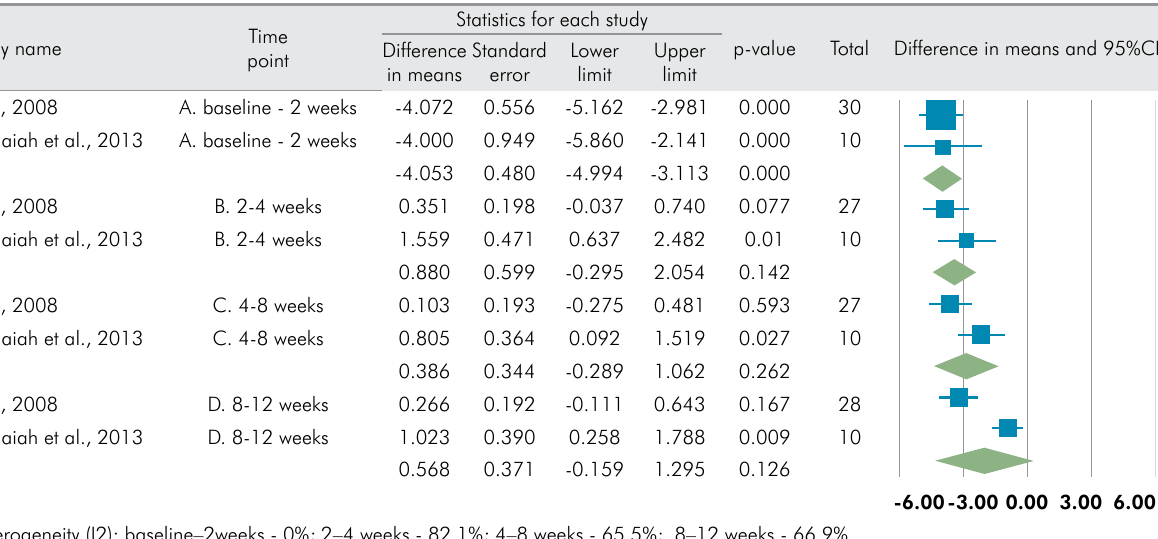
Figure 4. Comparison of measurements for the following time intervals: baseline–2, 2–4, 4–8, and 8–12 weeks of treatment. A: Data are presented in millimeters; B: Comparison using standard